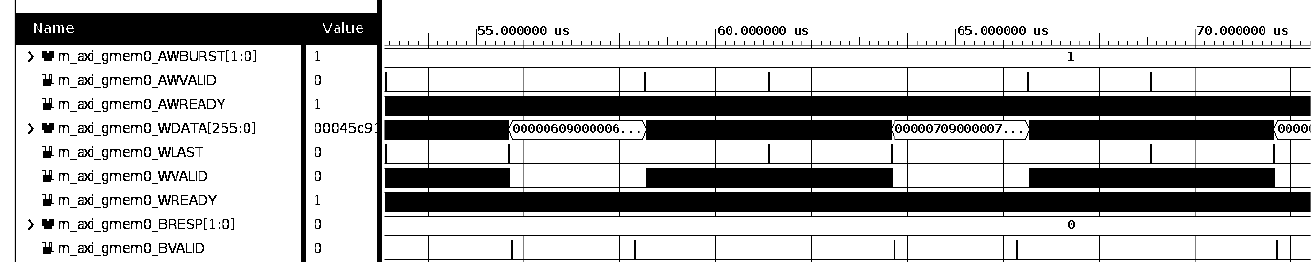
Figure 10. Results of simulation for a chunk length of 256 words. Waveform displayed with GTKWave. Approximately 74% of the AXI bus bandwidth is used.